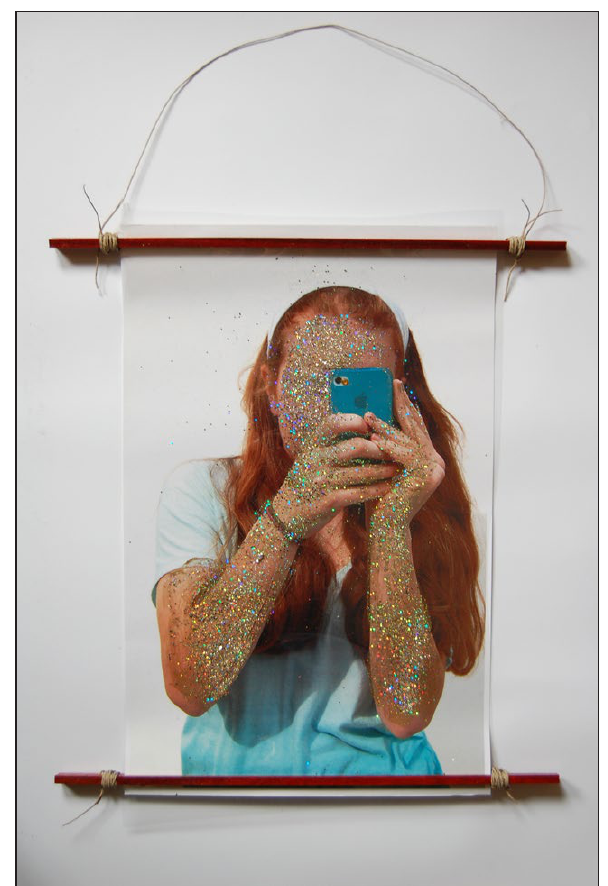
Figure 2: Brain Candy: iSight,